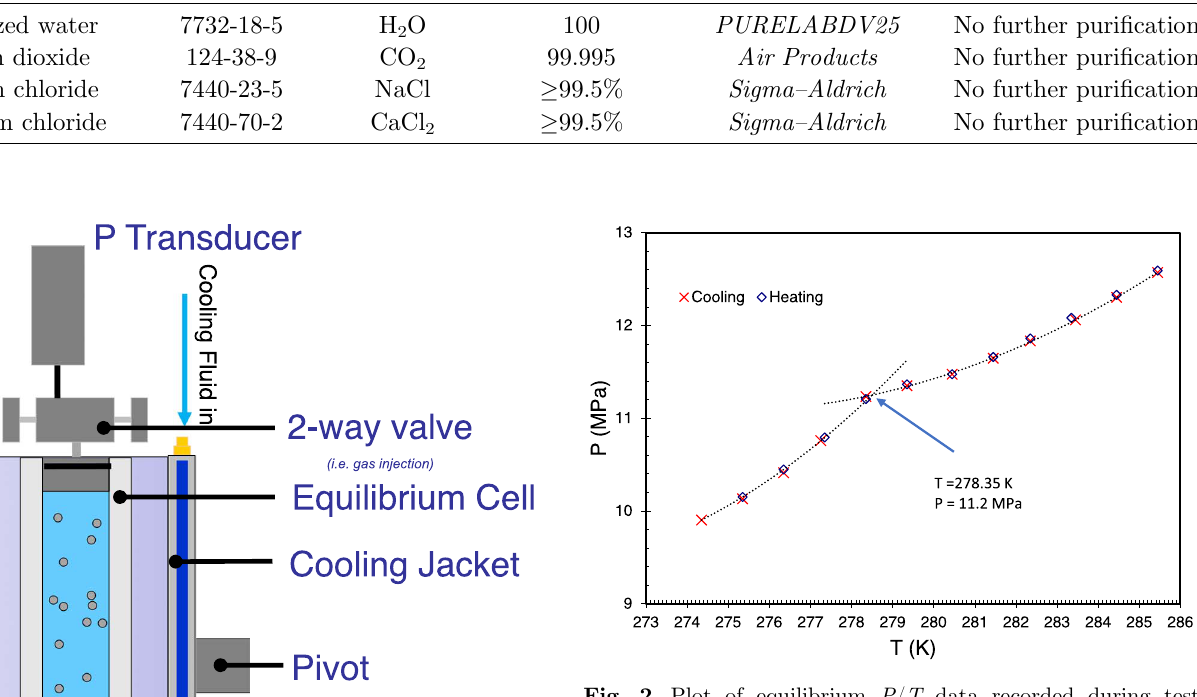
Fig. 2. Plot of equilibrium P / T data recorded during test x CO2 = 2.11 (cid:1) 10 (cid:3) 2 mole fraction in distilled water.